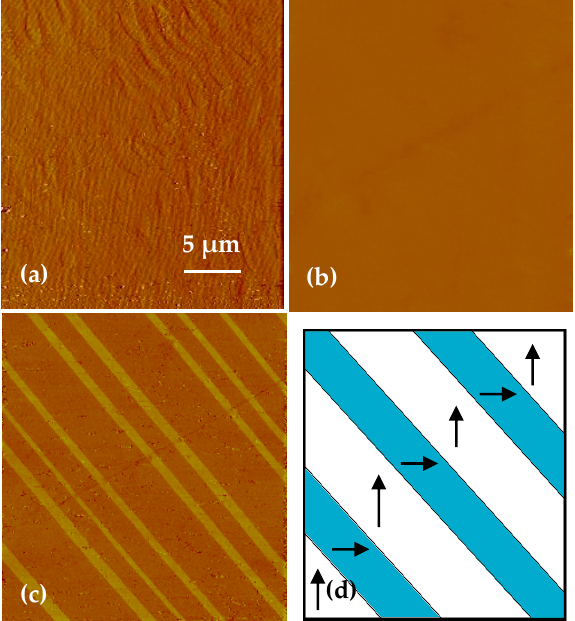
Figure 5. ( a ) AFM topography map of the 90 ◦ a-b domain structure at the (001) plane with a 40 nm Z scale and the roughness was 1.07 nm. ( b ) Surface potential map of the observed 90 ◦ a-b domain zone showing no contrast and no charge. ( c ) In-plane PFM map of the same area showing a typical 90 ◦ a-b domain structure. ( d ) Schematic of the measured a-b domain zone connected head to tail and perpendicular to each other.